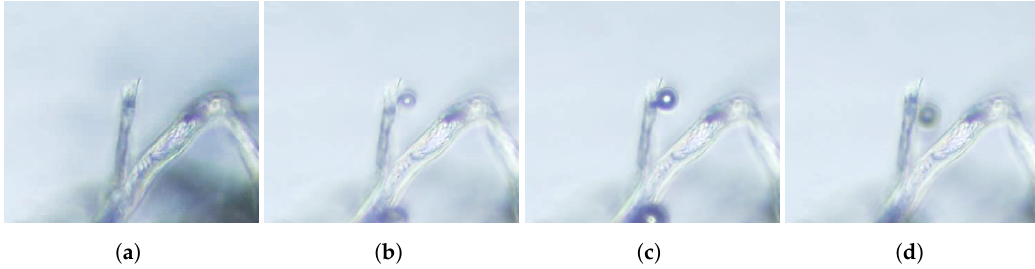
Figure 5. Microscope images, acquired by the authors, of bubble nucleation from a cellulose fiber at ( a ) t = 0 ms, ( b ) t = 300 ms, ( c ) t = 400 ms, and ( d ) t = 600 ms. The fiber is immersed in a petri dish containing freshly opened pale lager beer (Mahou Clásica), which has a bottling pressure of 5 bars ( ζ = 4). See video